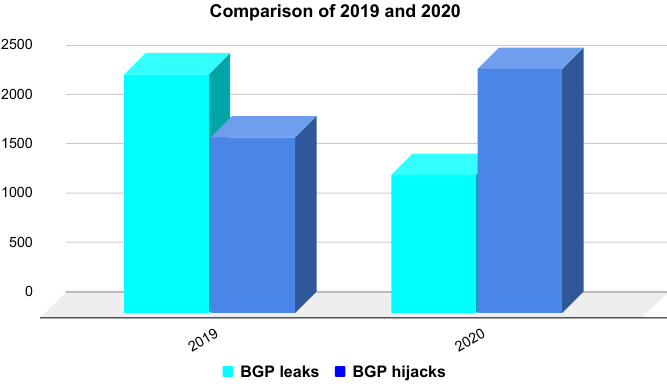
Figure 1. Comparison BGP events of 2019 and 2020